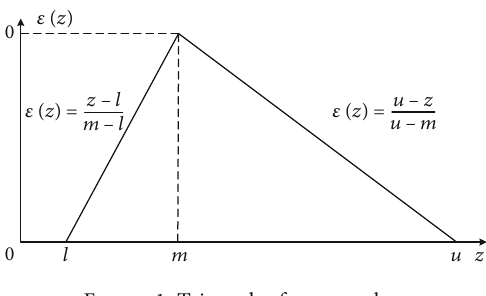
Figure 1: Triangular fuzzy number.